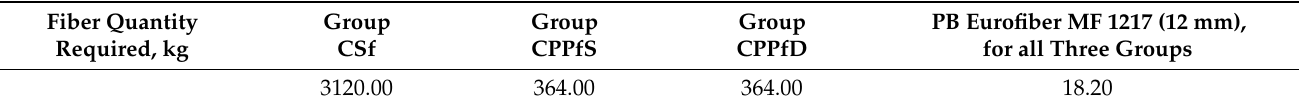
Table 3. Name of groups and fibers quantity, kg/m 3 a .